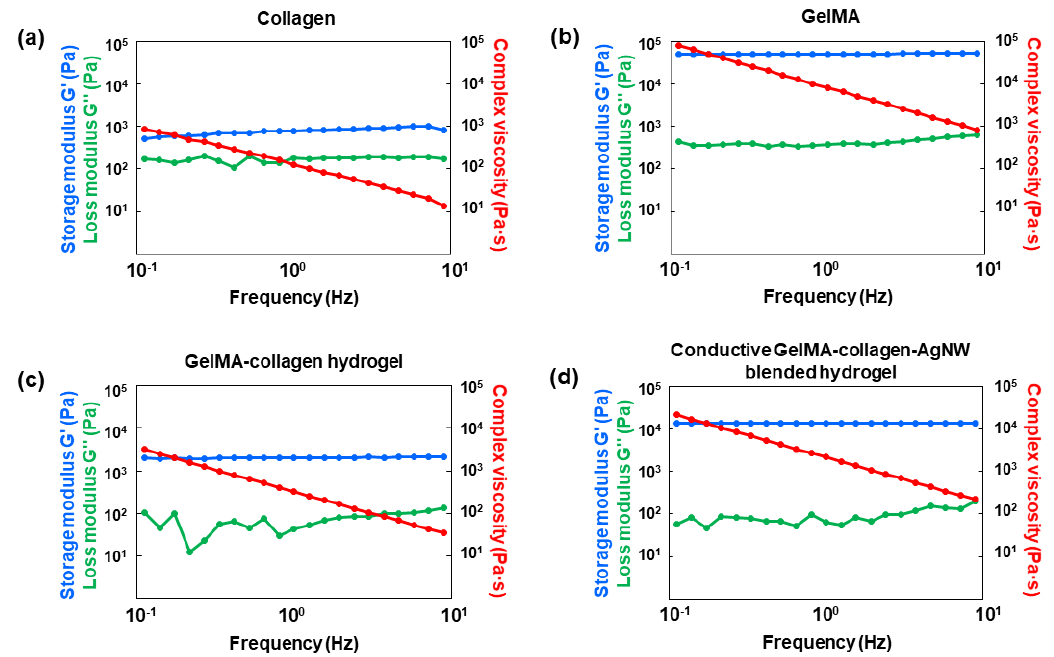
Figure 3. Rheological analysis of the conductive GelMA–collagen–AgNW blended hydrogel. Viscoelastic analysis of the collagen gel ( a ) and the GelMA hydrogel ( b ). Viscoelastic analysis of the GelMA–collagen hydrogel ( c ) and the conductive GelMA–collagen–AgNW blended hydrogel ( d ).